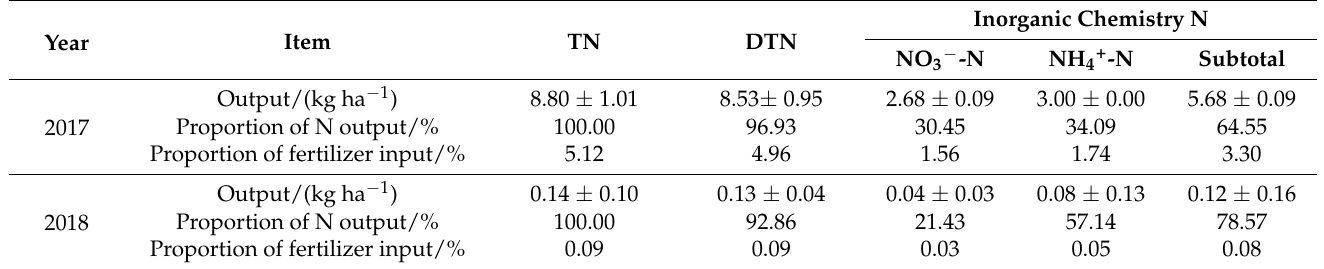
Table 5. Loss amount and rate of fertilizer N via surface runoff in peanut-growing season.